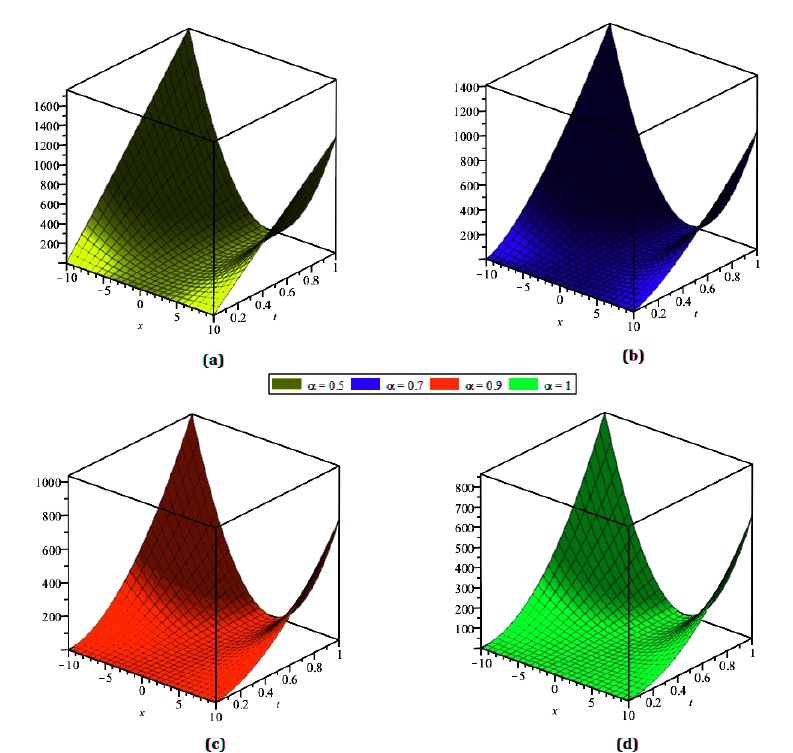
, B = 1, and y = 1 for distinct values of ℘ from 5